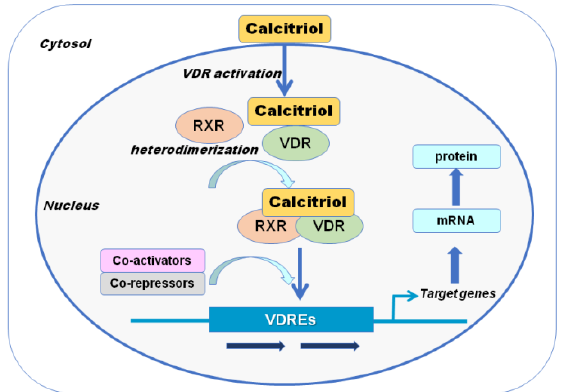
Figure 2. Vitamin D receptor (VDR) action at target cells. Intracellular calcitriol [1,25(OH) 2 D] binds to the VDR; thus, causing its dimerization with the retinoid X receptor (RXR). The ligand-bound VDR–RXR complex binds to structurally distinct vitamin D response elements (VDREs) in multiple, widely spaced vitamin D-responsive regions, and this causes a modification in the recruitment of co-activators or co-repressors, which leads to positive or negative transcriptional regulation of gene